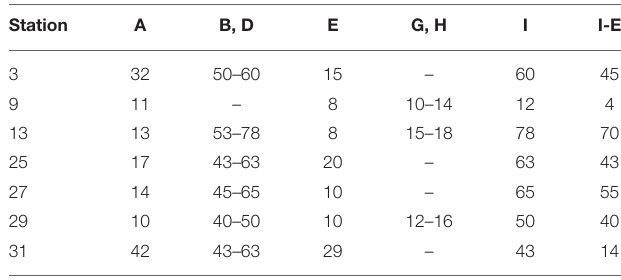
TABLE 5 | Depths of the features observed in the pore water profiles of NO − 3 , Mn and Fe as defined in Figure 4 . All values are in (cm).